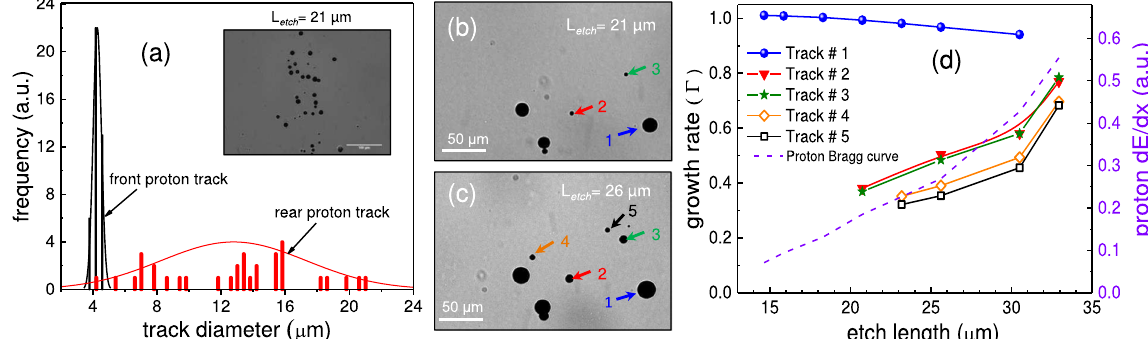
Figure 6. Characteristics of proton tracks appeared on the rear side of CR-39. ( a ) Distribution of the proton track diameters on the front and rear side of the CR-39. The inset shows microscopic images of 10 MeV protons appeared on the rear side of 1 mm thick CR-39. Zoomed track images of 10 MeV proton at two different bulk etching length of ( b ) 21 μ m and ( c ) 26 μ m. During the etching few tracks (track number 4 and 5) appear only after long bulk etch length. ( d ) The growth rate of selected proton tracks as a function of bulk etch length. The dotted line represent proton Bragg curve in